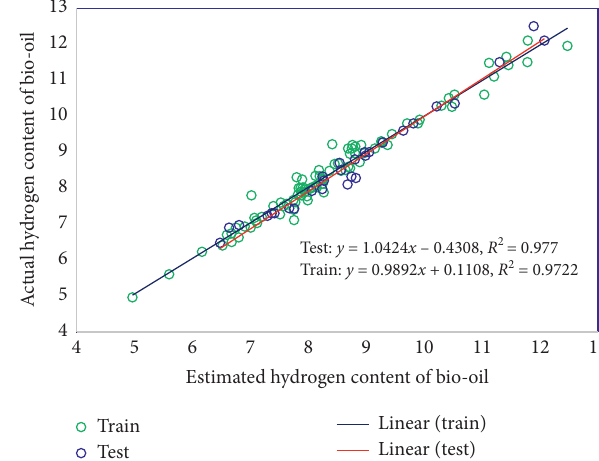
Figure 4: Cross-plot to evaluate the strength of the proposed model in predicting target